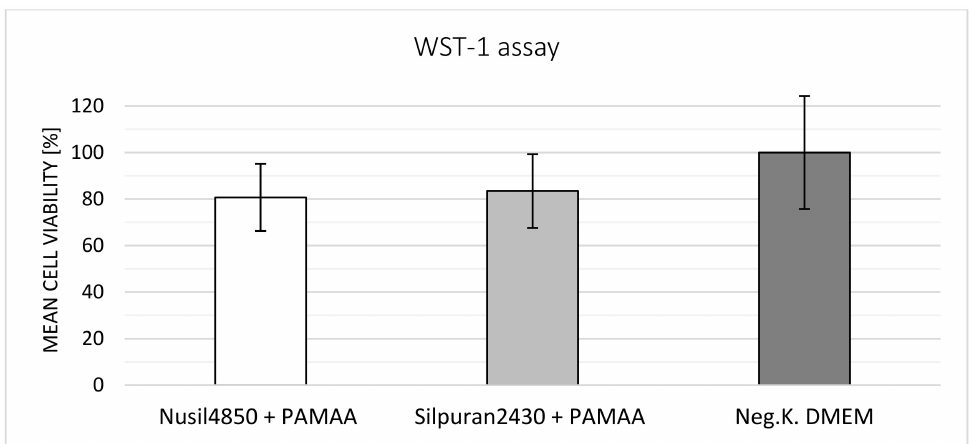
Figure 13. WST-1 biocompatibility results of Silpuran 2430-PAMAA and Nusil 4850-PAMAA samples repeated four times with n = 6 samples, mean ± standard deviation, and negative control. Mean cell viability for all repetitions corresponding to each material combination was calculated. All composites, irrespective of particle size and percentage of the hydrogel phase, yielded the same result of over 70% cell